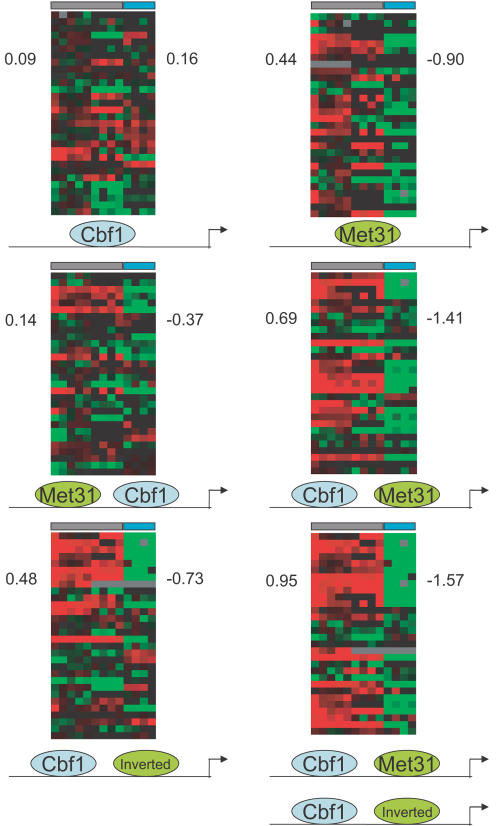
Met4 binding by Cbf1 and Met31 is dependent upon ordering but not orientation.We scanned all intergenic regions in yeast with the models presented in Fig. 1 with different orientations and orderings relative to the gene start point. We then ranked all genes in the genome based on the strength of their strongest upstream binding site, and we present here the corresponding expression changes as determined by microarrays. The experiments that each column represent correspond to those in Fig. 6. For columns 1–9 (marked with a gray box) we expect regulated genes to have increased expression and therefore to be red. For columns 10–13 (marked with a blue box) we expect regulated genes to have a decreased expression and therefore to be green. Since the Met31 matrix is asymmetric, it could bind with two different orientations. Those circles labeled “Met31” have the same orientation as the Met31 logo in Fig. 1. Those circles labeled “Inverted” have the opposite orientation (see Fig. 5). The optimal combination in the lower right corner allows for either orientation of Met31. The arrow signifies the gene start. The average expression change for the top 30 genes was calculated for each combination of sites for both the induced (columns 1 to 9) and repressed (column 10 to 13) experiments and are reported next to their respective columns.